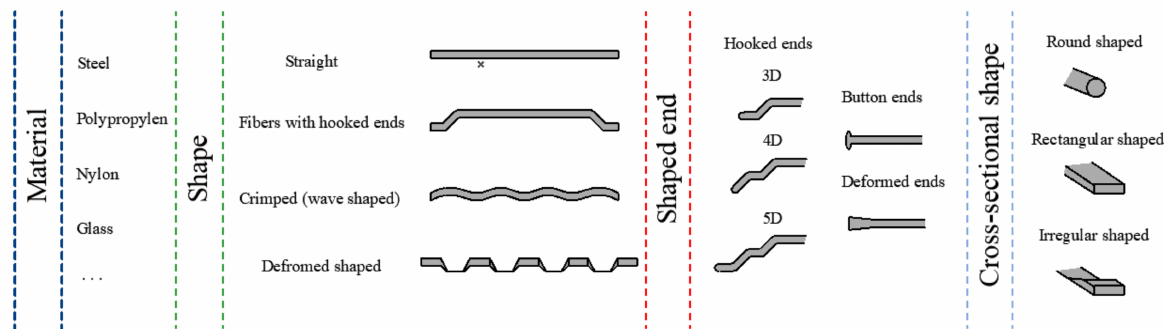
Figure 2. Types of fibers available for fiber-reinforced